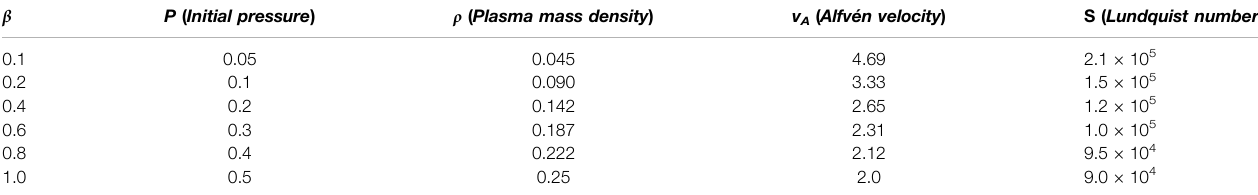
TABLE 1 | Dependence of the main parameters on the initial plasma- β β